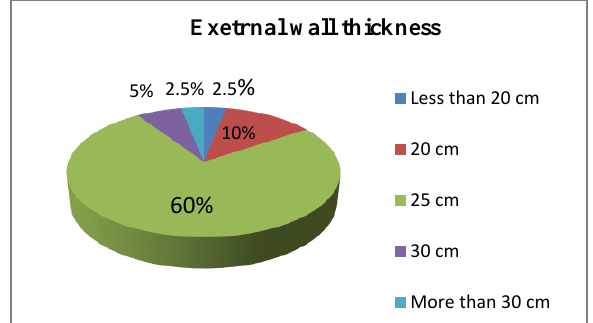
Figure 8. The above pie chart illustrates the external wall thickness in the Karakol residential buildings. This indicates that wall thickness has little impact on the annual energy